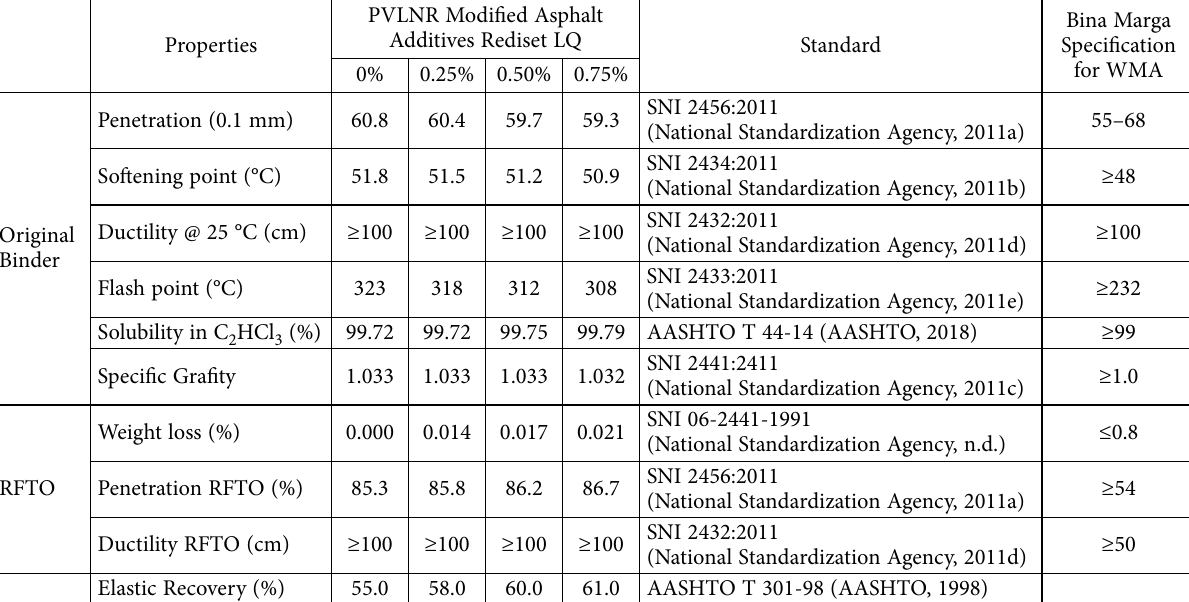
Table 4. PVLNR modified asphalt additive Rediset